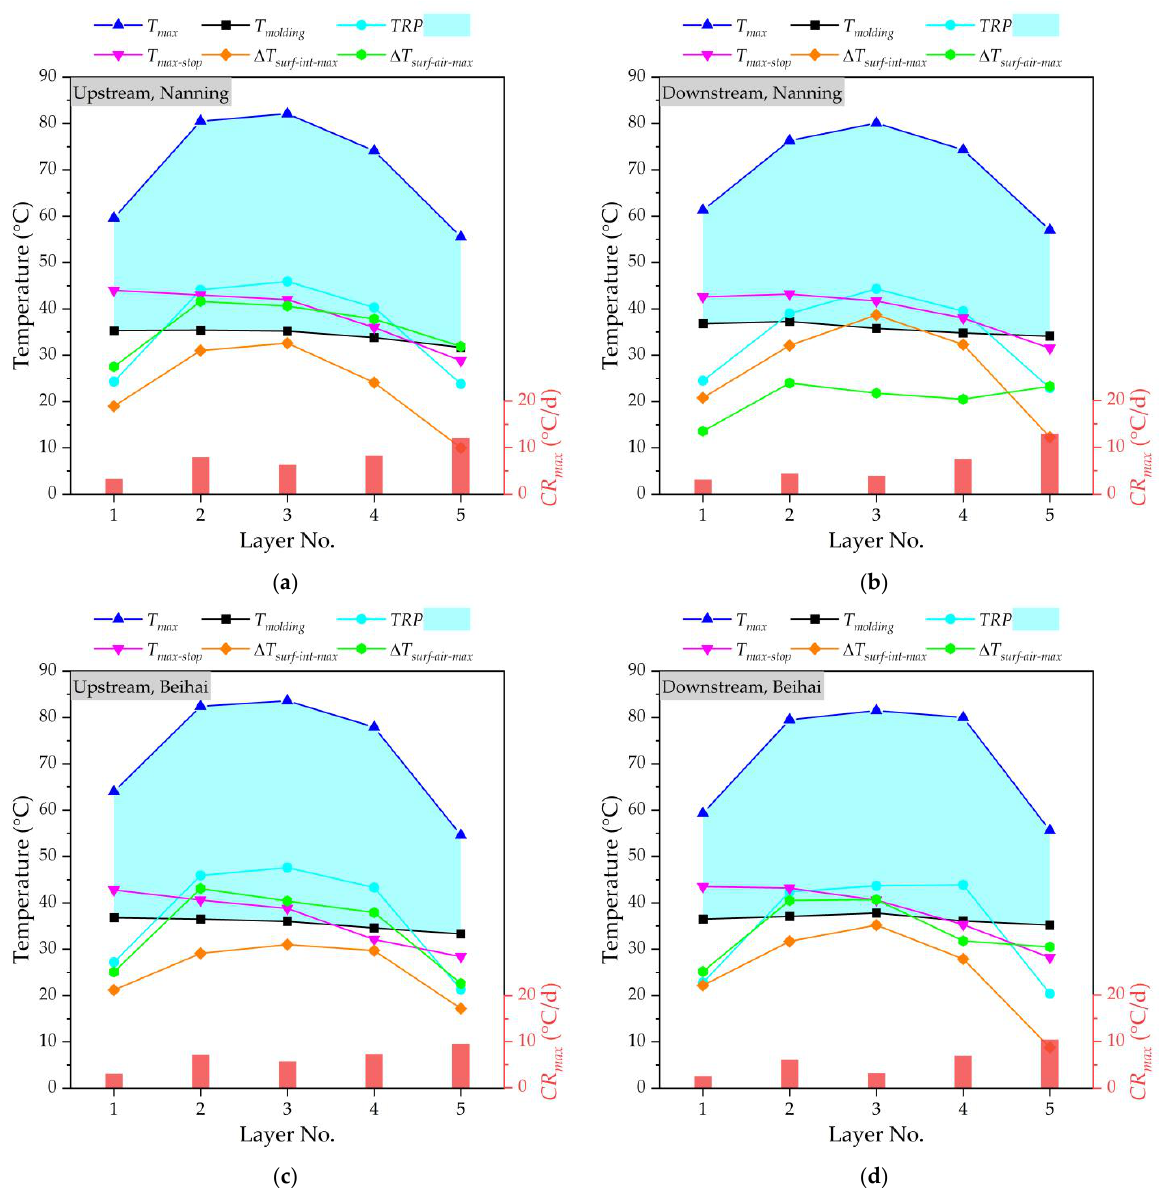
Figure 5. The temperature monitoring of mass concrete cushion cap: ( a ) at the upstream of Nanning side; ( b ) at the downstream of Nanning side; ( c ) at the upstream of Beihai side; ( d ) at the downstream of Beihai